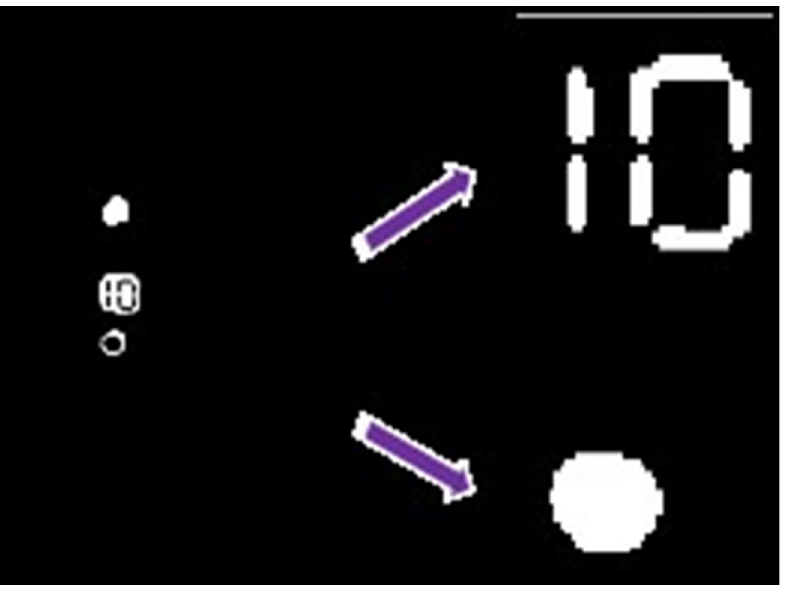
Fig 6. The extraction of the target region with the use of the halo